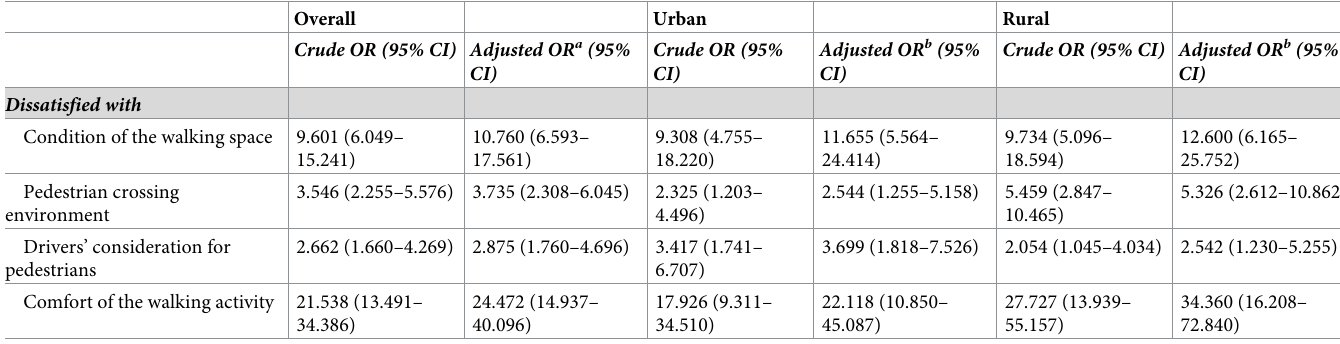
Table 3. Odds ratios of dissatisfaction with the walking-related environments. Overall Urban